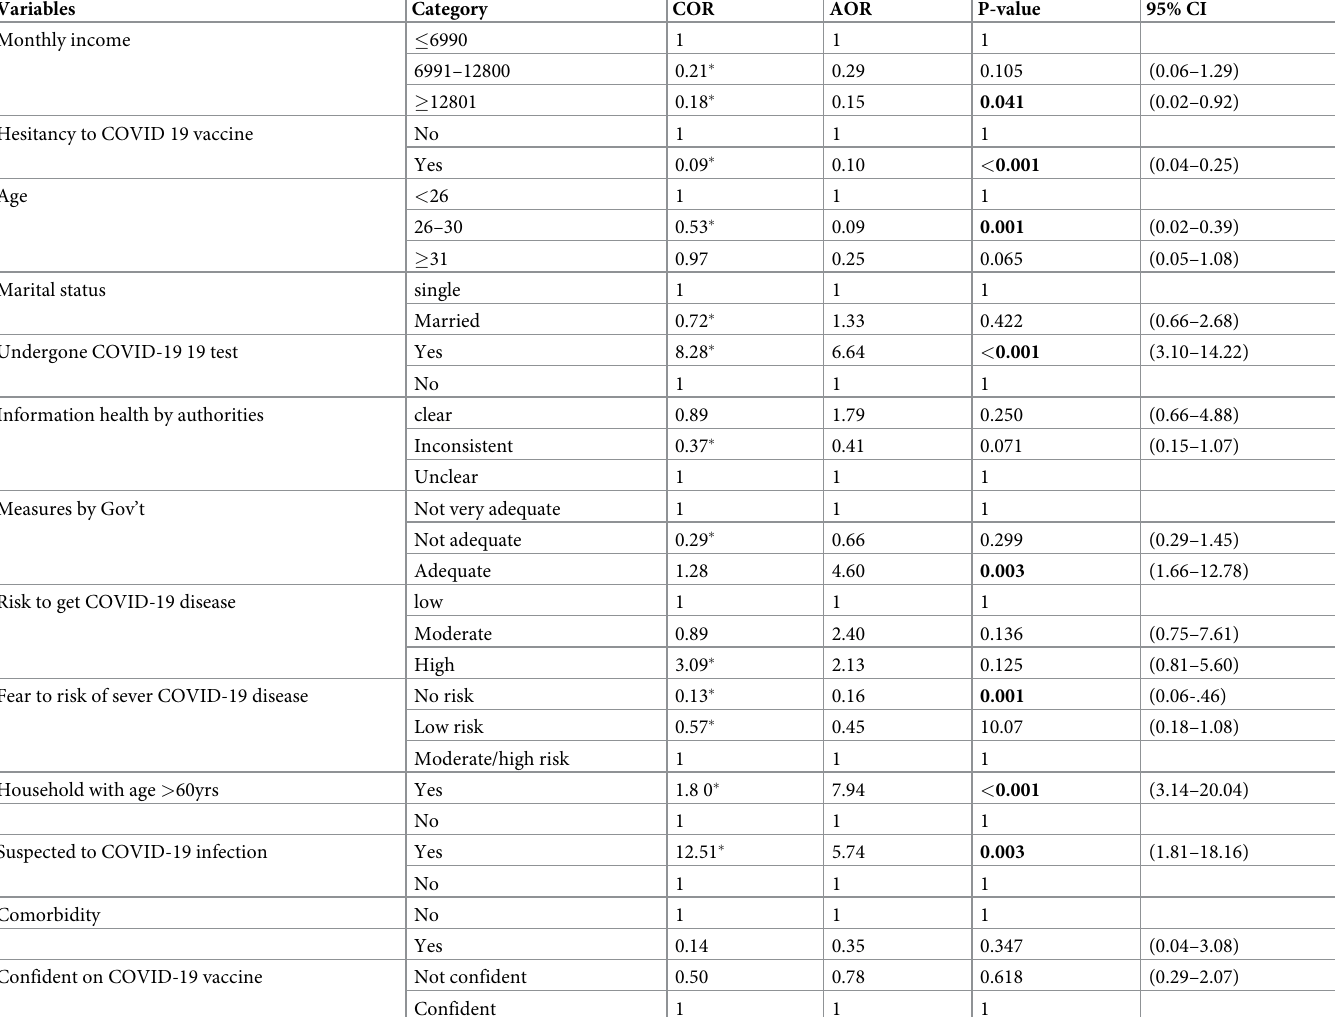
Table 3. Factors associated with adherence of COVID-19 mitigation measures among health care workers in referral hospitals of Amhara regional state of Ethiopia (N = 418). Variables